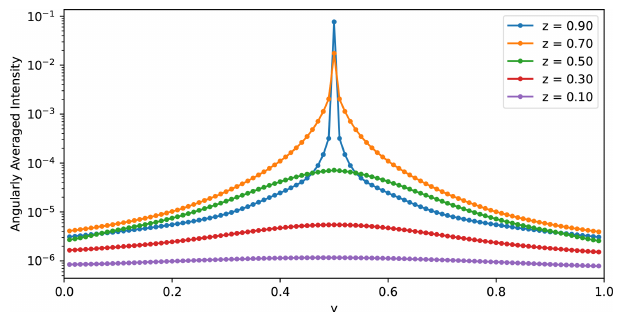
Figure 7. Cross sections of the angularly averaged intensity (ac- tinic flux) for a pencil beam problem. The medium is the Gaus- sian extinction field with the maximal optical depth of 40.0, single- scattering albedo of 1.0, and the Mie phase function with full an- gular accuracy (see text for details). This simulation is done with SHDOM using an increased 101 points in each dimension (10m resolution) to resolve the volumetric radiance field. The pencil beam source is located at the top of the center of the domain ( x = 0 . 5, y = 0 . 5, and z = 1 . 0) and pointed at nadir. Each colored line shows a single transect of the angularly averaged intensity at a different altitude.